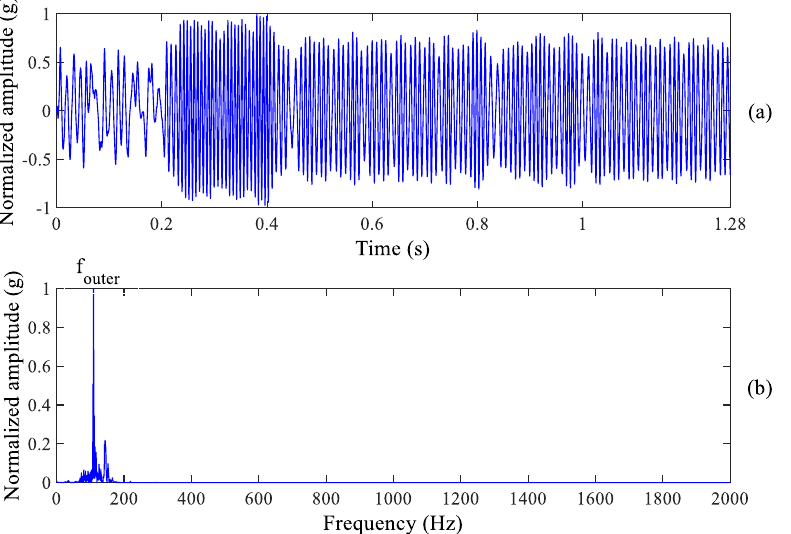
Figure 8. Outer race wear diagnosis result: ( a ) Enhanced signal ( b ) Zoomed frequency spectrum.